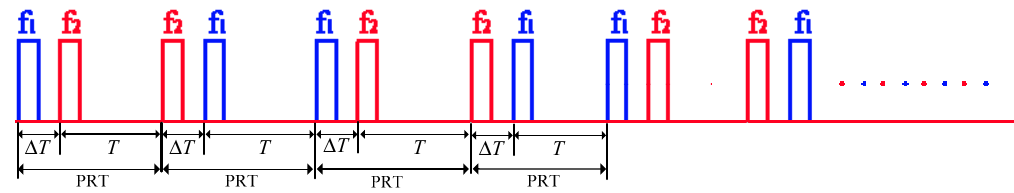
Figure 3. Illustration of a frequency diversity pulse-pair (FDPP) pulse transmission mode. Two pulses at different central frequencies of f 1 and f 2 are transmitted with a time interval Δ T . Generally speaking, Δ T is relatively small, only taking a few μ s or dozens of μ s. The combination of four pulses is a complete pulse repetition time. The difference between f 1 and f 2 is usually a few MHz or the value of radar band. PRT is the complete pulse repetition time.